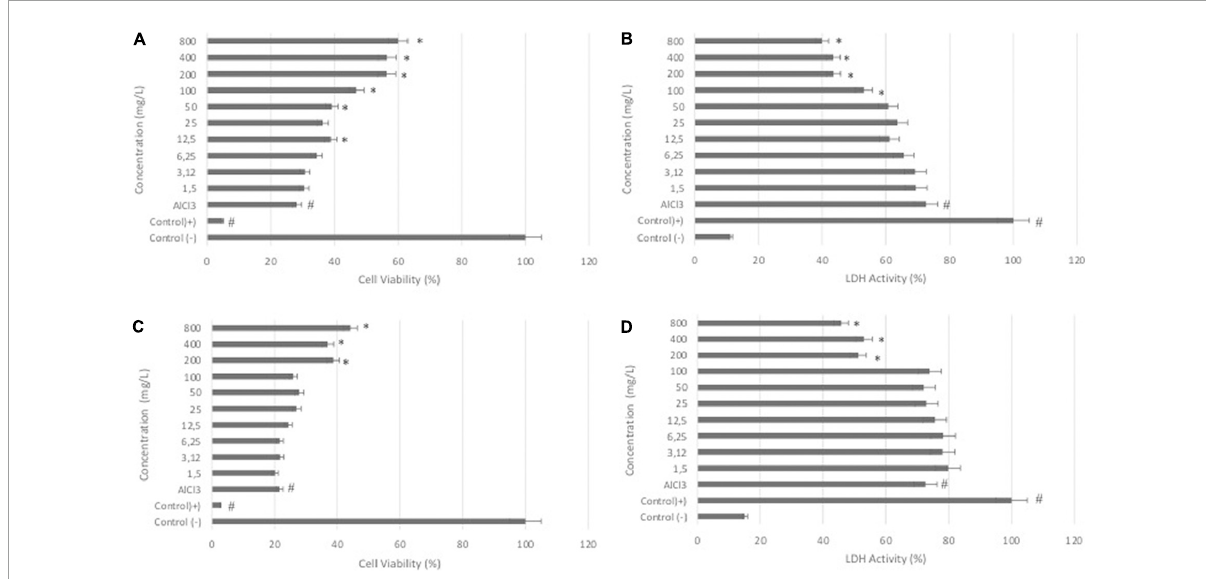
FIGURE1 Effects of DCS and LS against AlCl 3 -induced neurotoxicity in differentiated SHSY-5Y cells. (A) Viability of differentiated SHSY-5Y cells after 24 h of DCS (0-800 µ g/ml) and AlCl 3 treatment. (B) LDH activity of cells after 24 h of DCS (0-800 µ g/ml) and AlCl 3 treatment. (C) Viability of differentiated SHSY-5Y cells after 24 h of LS (0-800 µ g/ml) and AlCl 3 treatment. (D) LDH activity of cells after 24 h of LS (0-800 µ g/ml) and